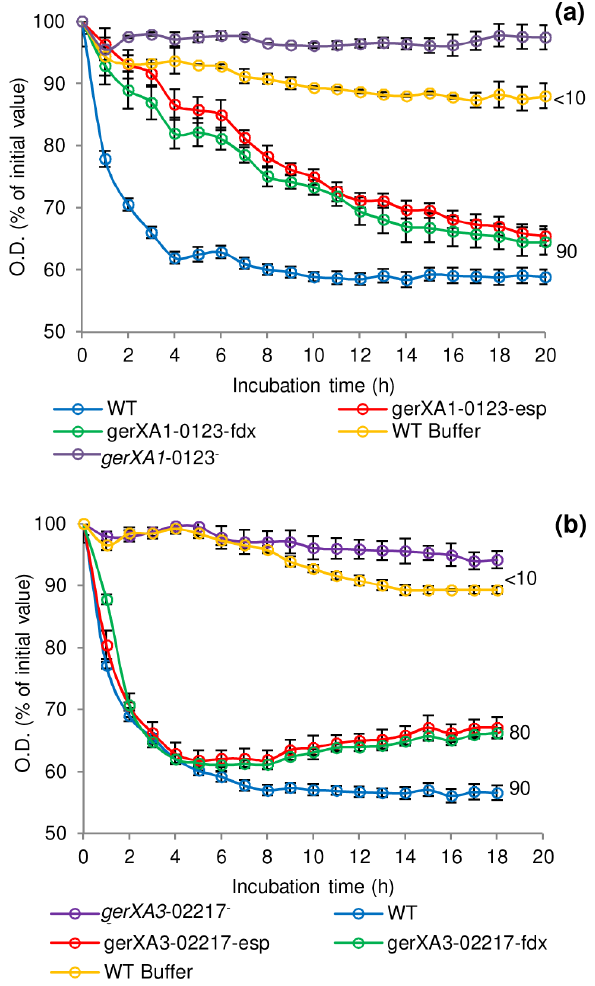
Figure 5. Germination rates of complemented GR mutants for C.botulinum and C.sporogenes . Spores were incubated in 20 mM Tris buffer, pH 7.4, amino acid (100 mM) + L-lactate (50 mM) + NaHCO 3 (50 mM) at 30 u C with L-cysteine ( C. botulinum ), L-alanine ( C. spor- ogenes ). (a) C. botulinum mutant gerXA1 -0123 2 complemented with plasmid pMTL8315esp ( gerXA1 -0123 2 esp) or plasmid pMTL8315fdx ( gerXA1 -0123 2 fdx). (b) C. sporogenes mutant gerXA3 -02217 2 comple- mented with plasmid pMTL8315esp ( gerXA3 -02217 2 esp) or plasmid pMTL8315fdx ( gerXA3 -02217 2 fdx). There were two negative controls. Firstly, the uncomplemented mutant ( gerXA1 -0123 2 or gerXA3 -02217 2 ), secondly WT spores incubated in 20 mM Tris buffer (pH 7.4) + L-lactate (50 mM) + NaHCO 3 (50 mM) only (WT Buffer). Spore germination was confirmed by phase contrast microscopy. Error bars represent the standard deviation of 3 independent experiments. Data labels (right) refer to percentage germination observed by phase contrast micros- copy at the end of the experiment.